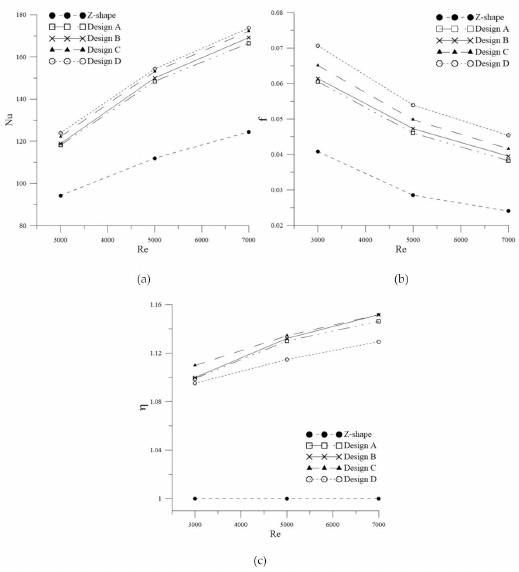
Figure 11. The variations of ( a ) Nu, ( b ) f and ( c ) η with Re for various